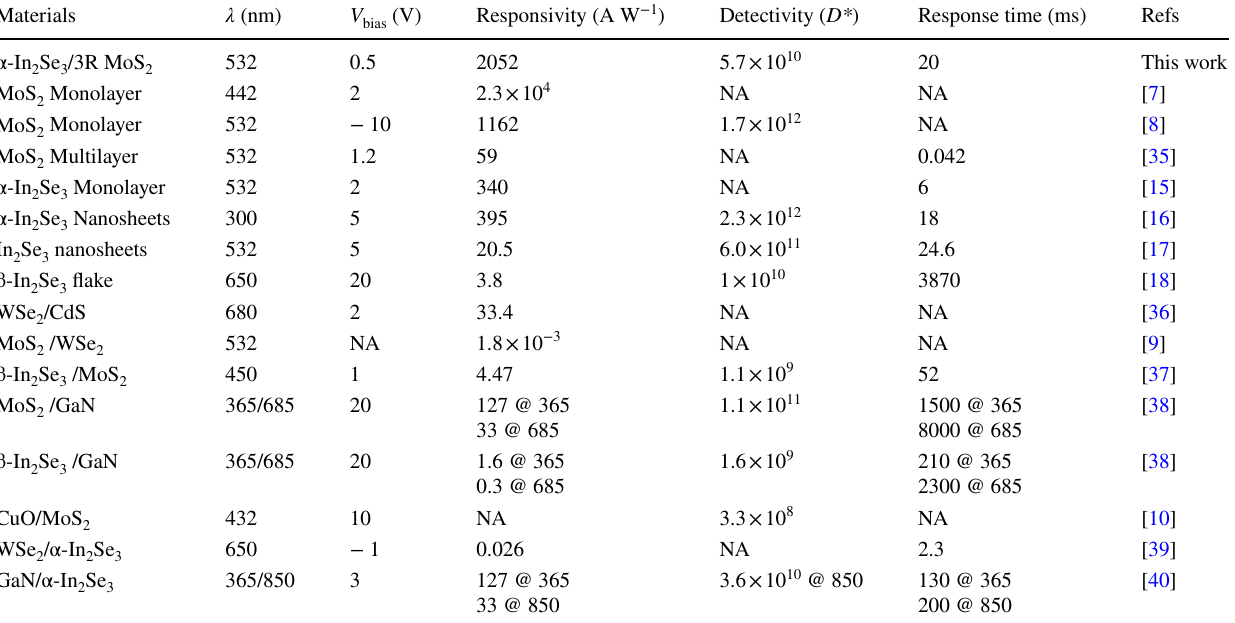
Table 1 Comparison of the characteristic parameters of our present heterojunction devices with other 2D materials-based photo devices